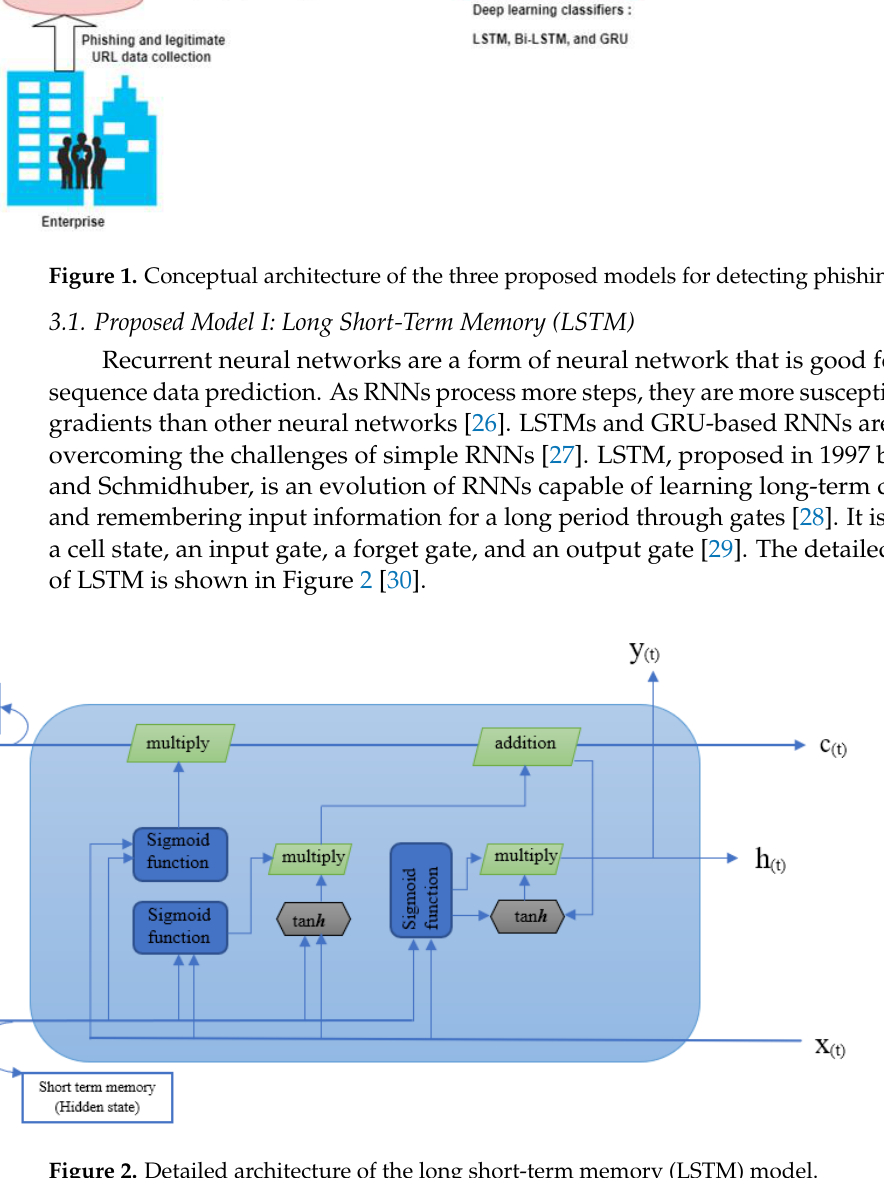
Figure 2. Detailed architecture of the long short-term memory (LSTM) model.